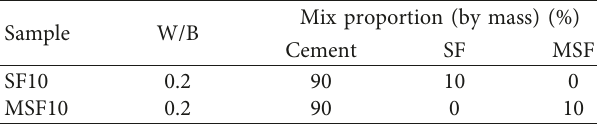
Table 5: The mix proportion of cementitious paste.